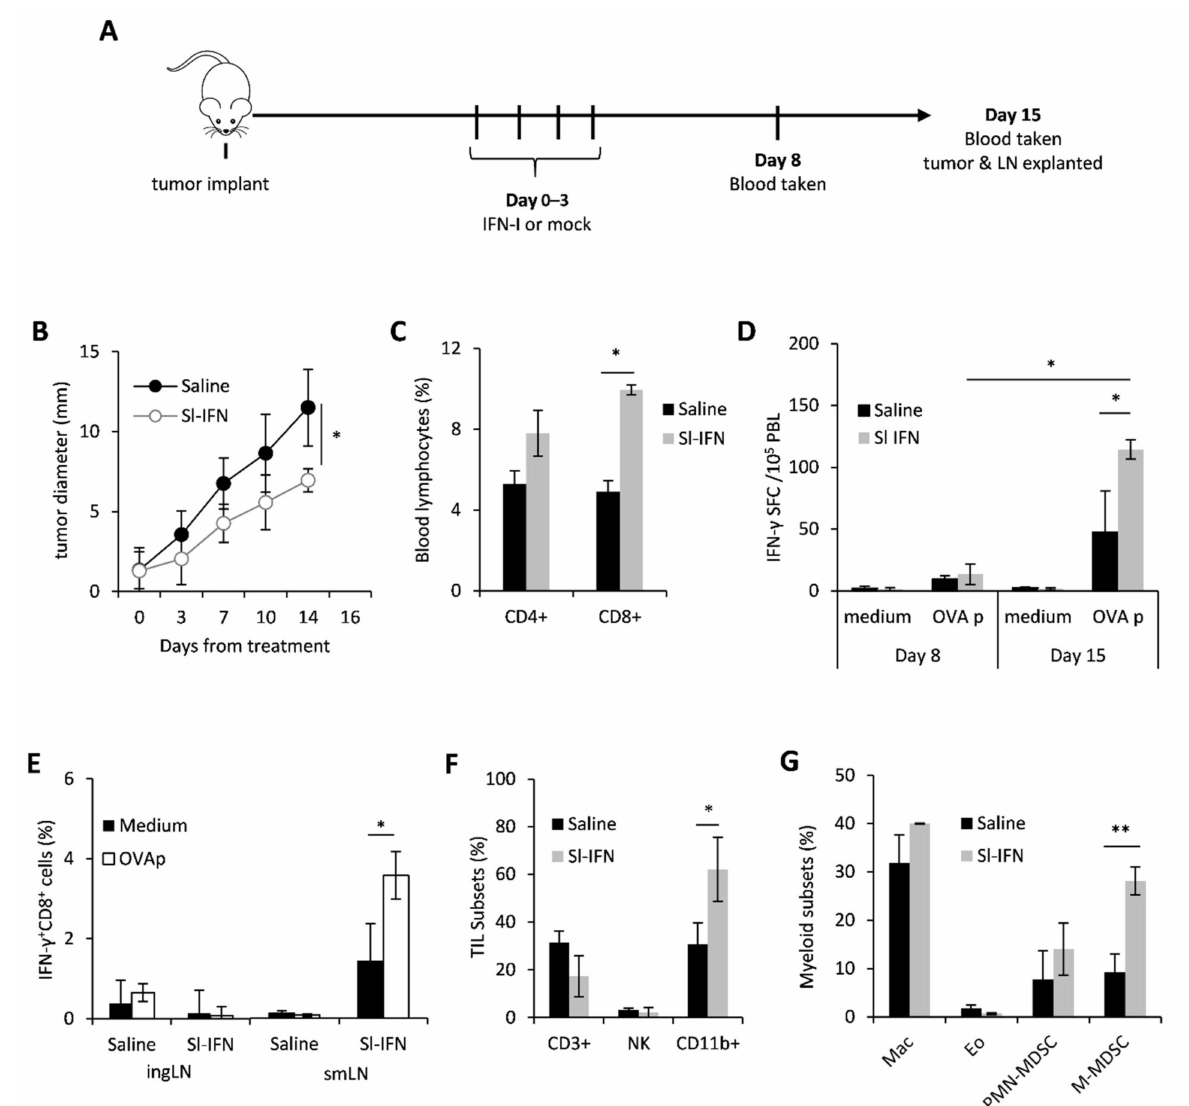
Figure 1. Anticancer effect of sublingual IFN in B16 melanoma. ( A ) Schematic representation of the experimental design. ( B ) Tumor size after sublingual treatment with IFN-I or with Saline as control ( n = 5). ( C ) Percentage of CD3 + CD4 + and CD3 + CD8 + T lymphocytes in the blood of tumor-bearing mice treated as indicated, 14 days after Sl-IFN treatment initiation ( n = 5). ( D ) IFN- γ ELISpot in peripheral blood leucocytes (PBL) of C57Bl/6 female mice implanted with B16-OVA treated with Sl-IFN or Saline as control ( n = 5). Tests have been performed on day 8 and 15 from treatment. ( E ) Percentage of IFN γ + CD8 + cells in the ingLN and smLN of C57Bl/6 female mice implanted with B16-OVA treated with Sl-IFN or Saline as control ( n = 5). Assay was performed 15 days after treatment initiation after 5 h stimulation of LN suspensions with OVA peptide (OVAp) or PMA and Ionomycin (PMA/I). ( F ) Percentage of CD3 + , NK1.1 + and CD11b + cells in tumor masses from C57Bl/6 female mice implanted with B16-OVA 15 days after treatment with Sl-IFN or Saline ( n = 4). ( G ) Percentage of myeloid subsets in the tumor mass of mice treated with Sl-IFN or Saline 15 days after treatment ( n = 4). * p < 0.05, ** p <